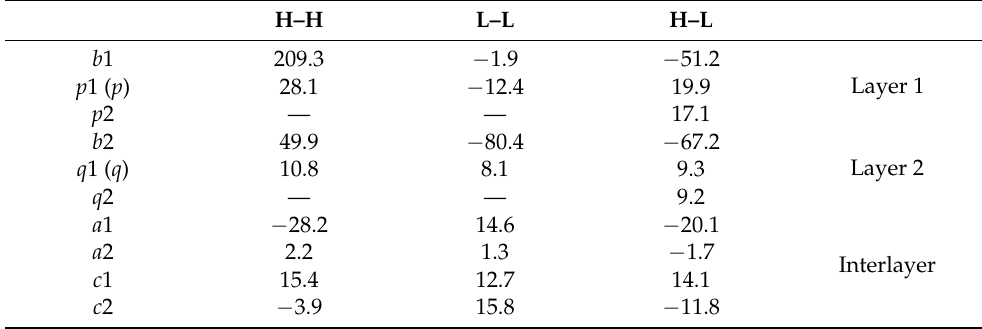
Table 1. HOMO–HOMO (H–H), LUMO–LUMO (L–L), and HOMO–LUMO (H–L) transfer integrals (meV) at 5.9 GPa.